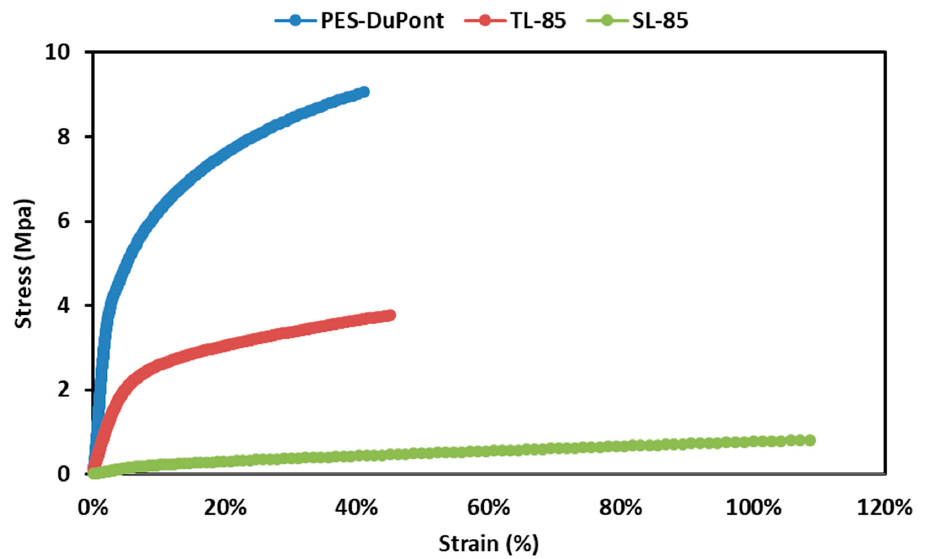
Figure 4. Stress-strain curve of the triple layer membrane, PES and the single layer PVDF membrane.